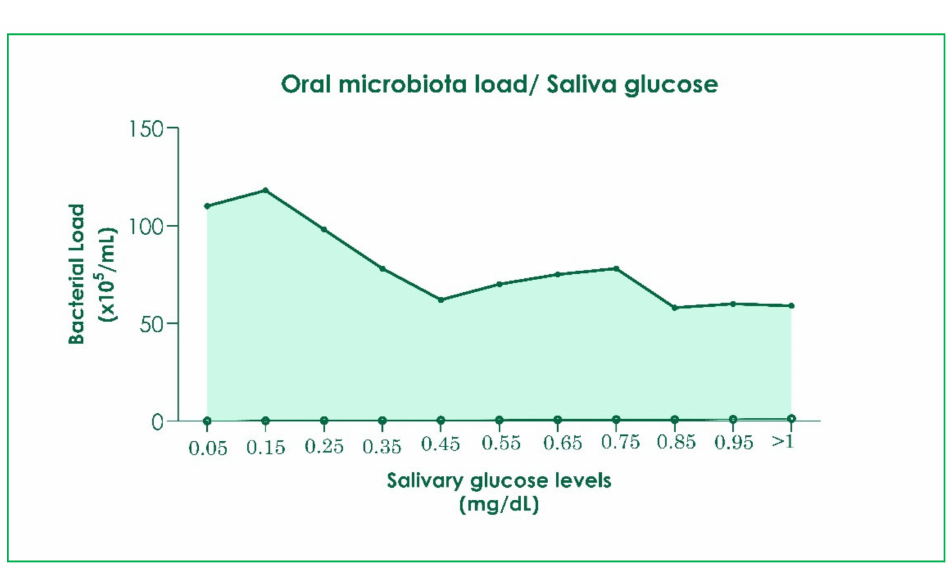
Figure 1. Deflection curve of OM load with an increase of glucose in saliva